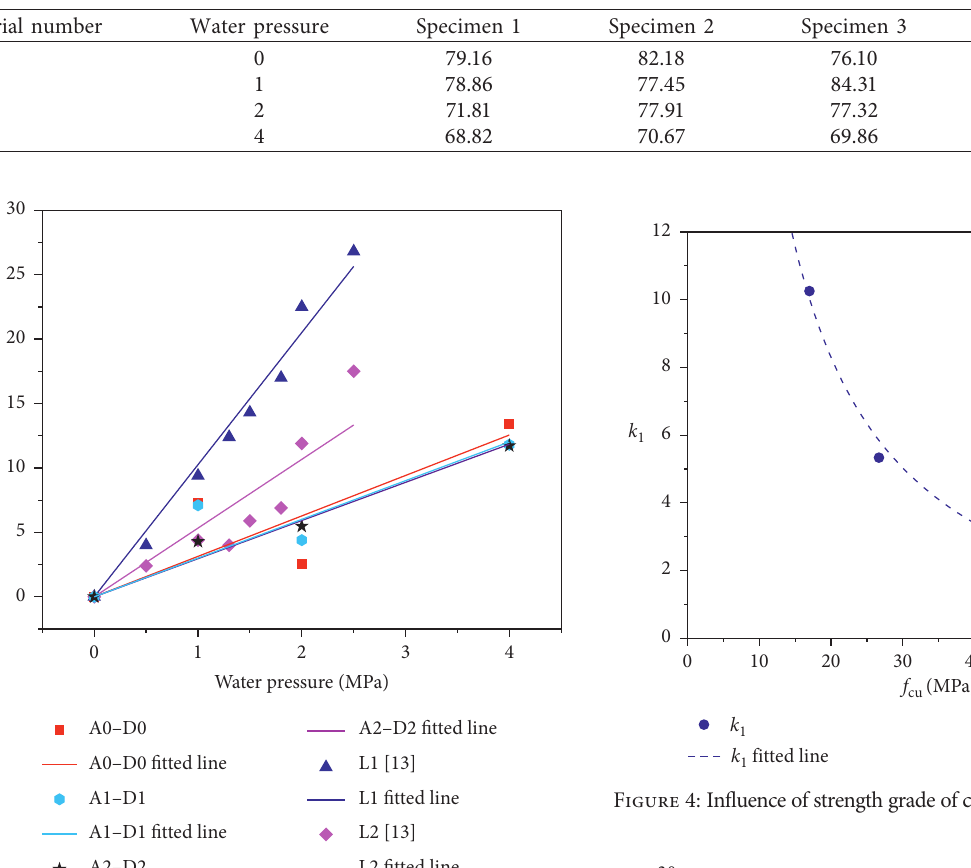
Table 4: Static compressive strength of concrete under different water pressure/MPa (disc specimens).